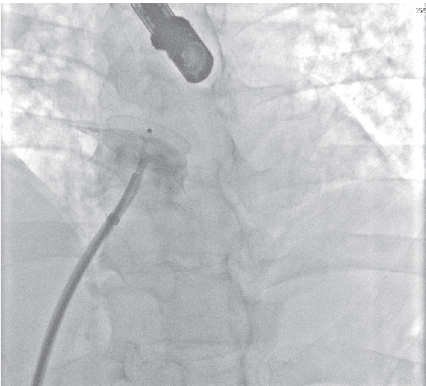
Figure 1: Right atrial angiography demonstrating patent foramen ovale closure device position prior to device release.